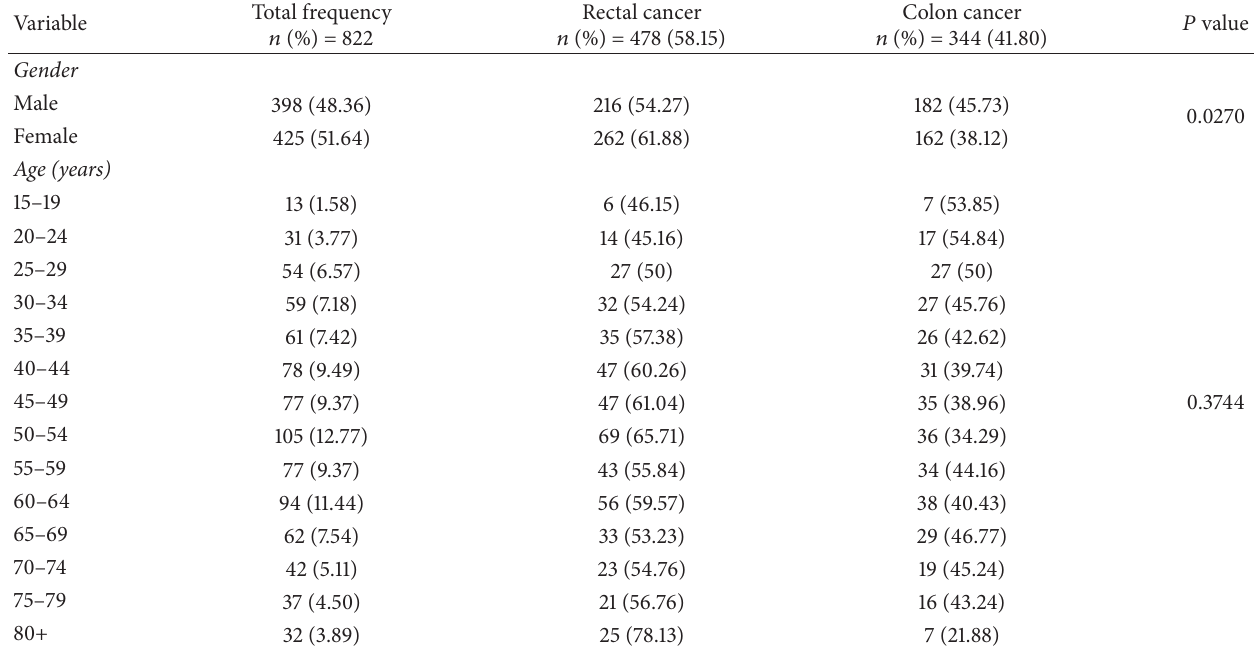
Table 3: Percentage distribution of colon and rectal cancer by gender and age.